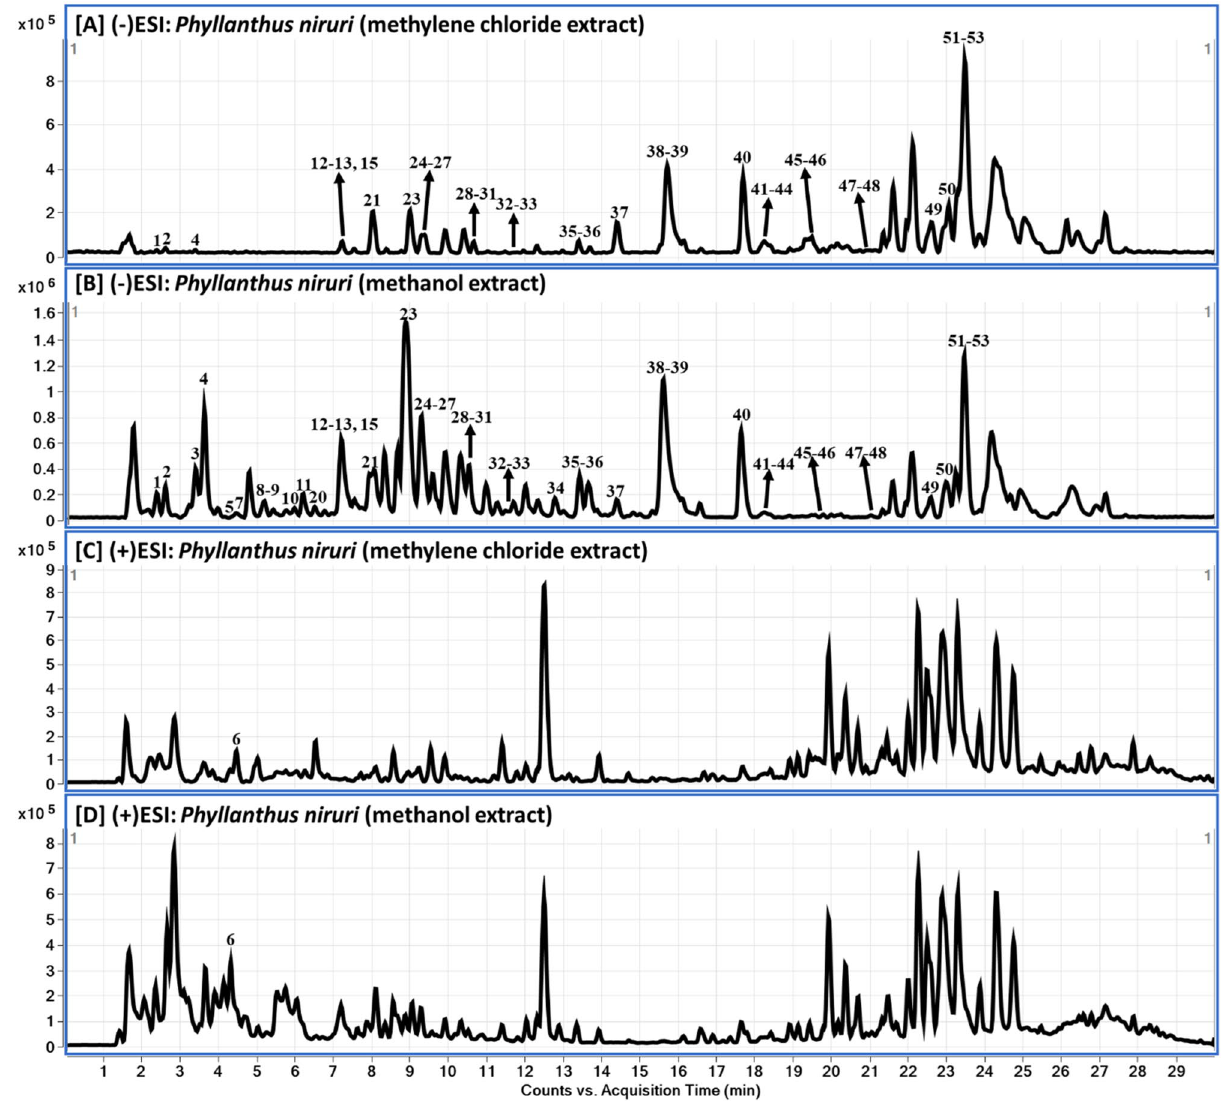
Figure 1. LC-QToF total Ion Chromatograms (TOC) of the CH 2 Cl 2 and MeOH extract of P. niruri : in negative ( A , B ) and positive modes and ( C , D